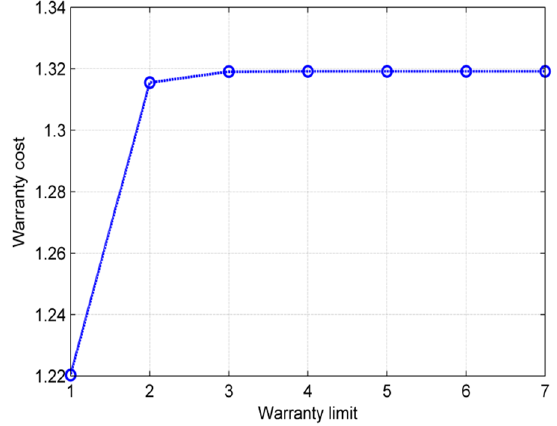
Figure 2. Warranty cost versus m .